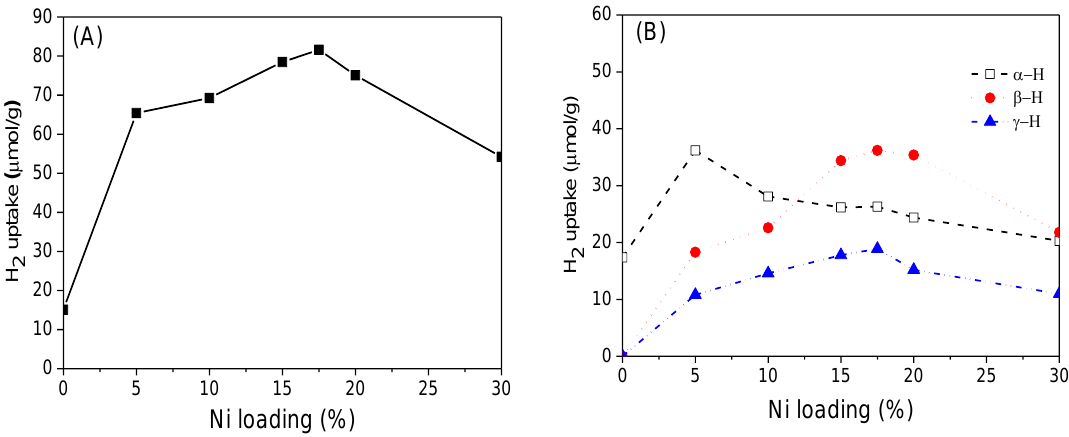
Figure 10. The total ( A ) and site-defined ( B ) hydrogen uptake on the xNi/CeO 2 catalyst.